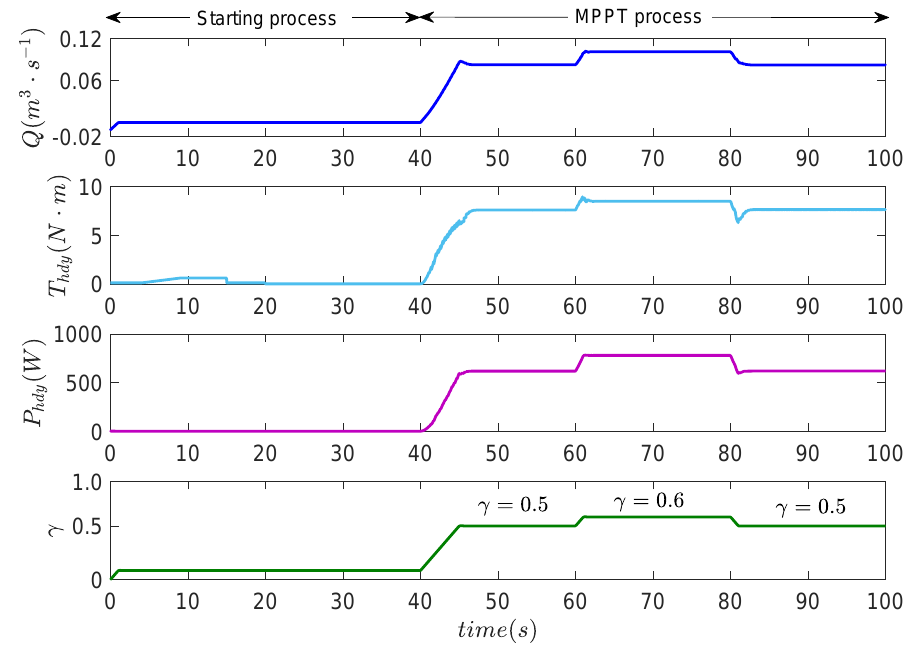
Figure 13. Hydraulic dynamics process in the offline